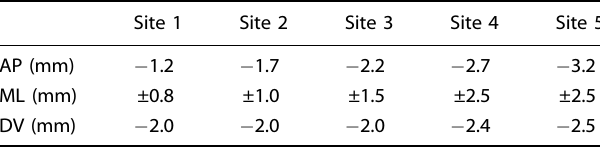
Table 1. Stereotaxic coordinates employed for the injections of